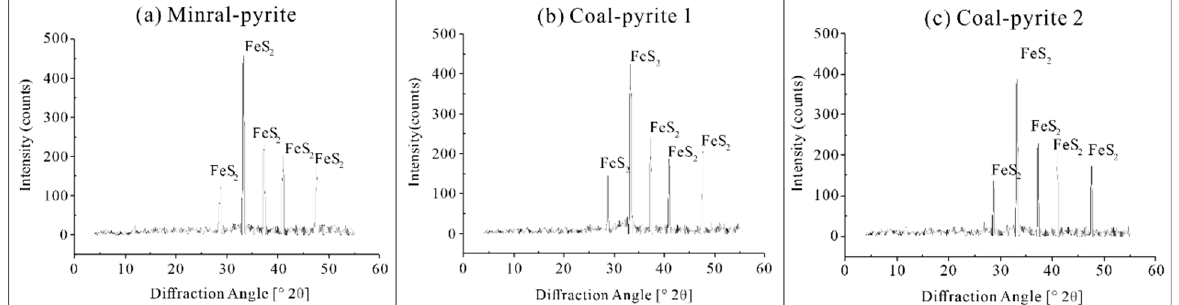
Figure 3. XRD patterns of coal-pyrite and mineral pyrite samples: ( a ) is the mineral-pyrite (M1); ( b ) is the coal-pyrite from Jiashun coal mine (C1); ( c ) is the coal-pyrite from Xiongxin coal mine (C2).